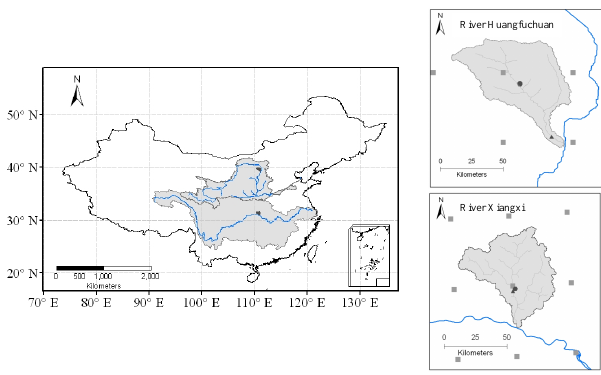
Figure 1. Location of selected subcatchments in the Yellow River and Yangtze River and climate stations (black circles), discharge stations (black triangles), and climate research unit (CRU) grid nodes (grey